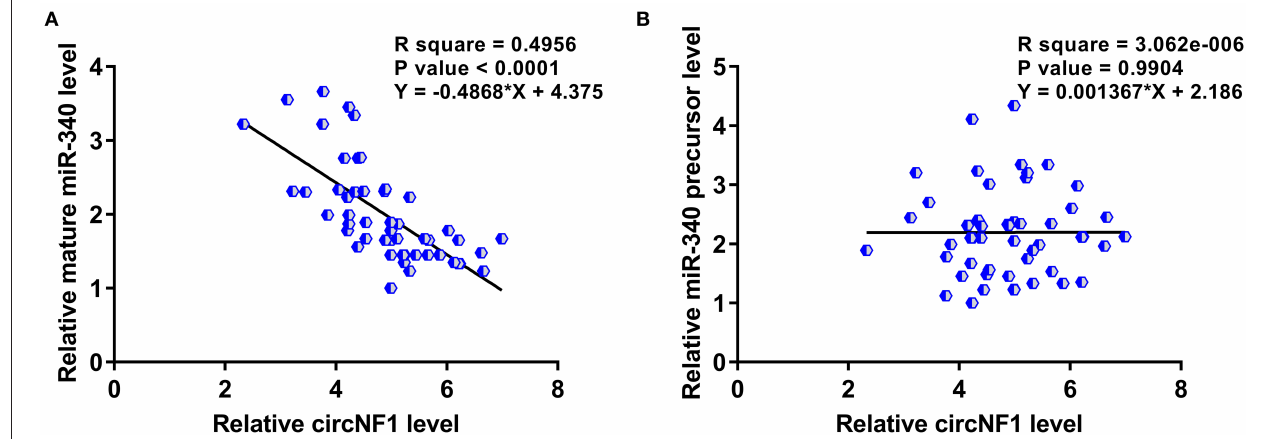
FIGURE 3 | circNF1 was inversely correlated with mature miR-340 across glioblastoma (GBM) tissues. Correlations between circNF1 and (A) mature miR-340 or (B) miR-340 precursor across GBM tissues were analyzed using Pearson’s correlation coefficient.